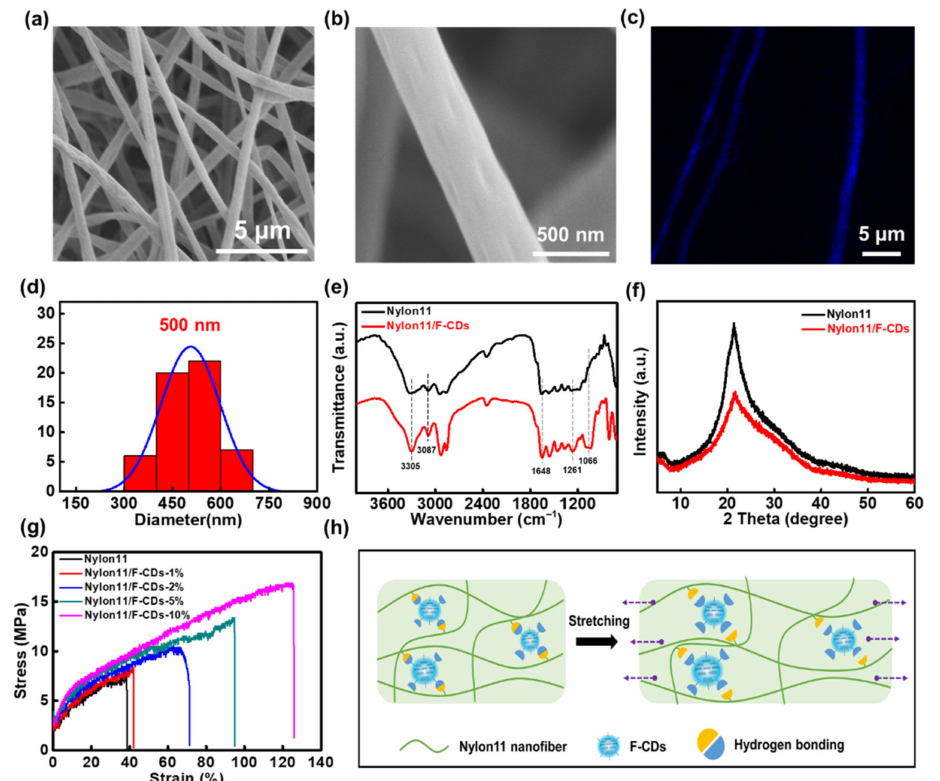
Figure 5. ( a , b ) SEM images of Nylon-11/F-CD nanofiber mats. ( c ) Fluorescent image of Nylon11/F- CD nanofiber mats acquired by a laser scanning confocal microscope. ( d ) Diameter distribution of Nylon-11/F-CD nanofiber mats. ( e ) FT-IR and ( f ) XRD spectra of Nylon-11 and Nylon-11/F-CD nanofiber mats. ( g ) Strain–stress curves of Nylon-11/F-CD nanofiber mats with different concen- trations. ( h ) Schematic diagram of the mechanical enhancement mechanism of Nylon-11/F-CD nanofiber